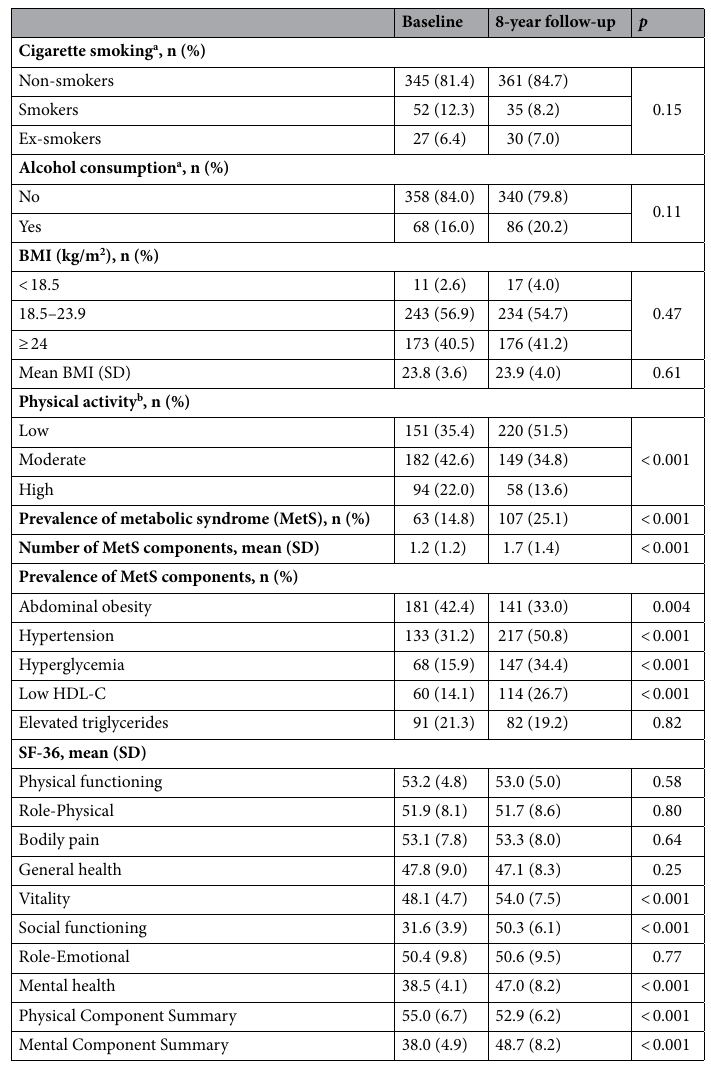
Table 2. Characteristics of the study population at baseline and the eight-year follow-up (n = 427). Chi-square tests were used for categorical variables. T-tests were used for continuous variables. BMI body mass index, SD standard deviation, MetS metabolic syndrome. a There were few missing data in these covariates. b Physical activity was evaluated by the International Physical Activity Questionnaire (IPAQ) Short-Form, Taiwan